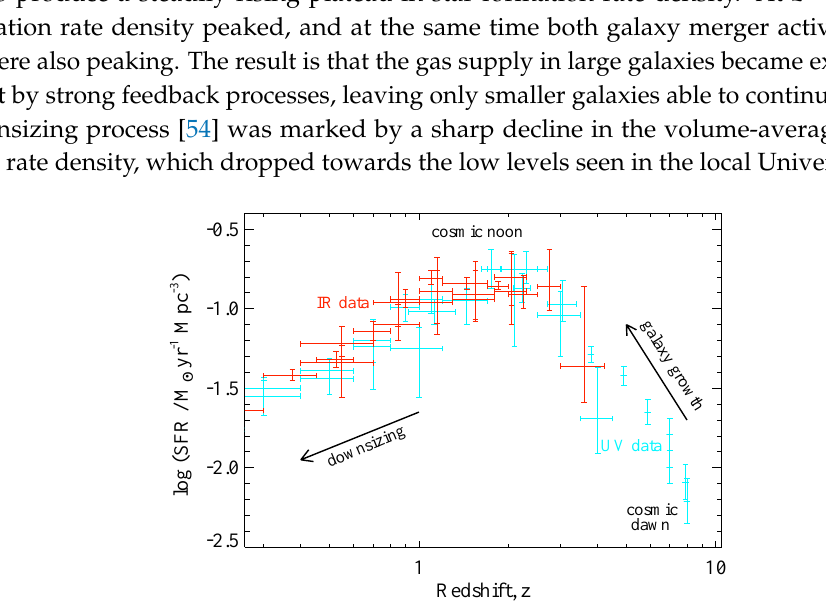
Figure 1. The cosmic, volume-averaged star formation rate density history as a function of redshift. Data points show the compilation of (Madau and Dickinson [10]; see references therein as well), with infrared-derived and dust-corrected ultraviolet-derived star formation rates distinguished by colour. The volume-averaged flux measured by each data set has been calibrated by Madau and Dickinson [10] against stellar population synthesis models. UV-derived rates are also subject to large corrections for assumed dust extinction, which remains uncertain at the highest redshifts. The rise in volumetric star formation rate from Cosmic Dawn to the peak at Cosmic Noon, followed by a decline as star formation downsizes, is clearly